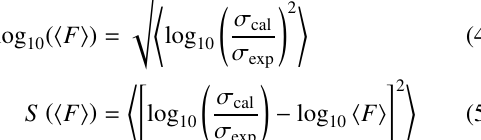
F of each calculation for lead and bismuth ⟨ ⟩